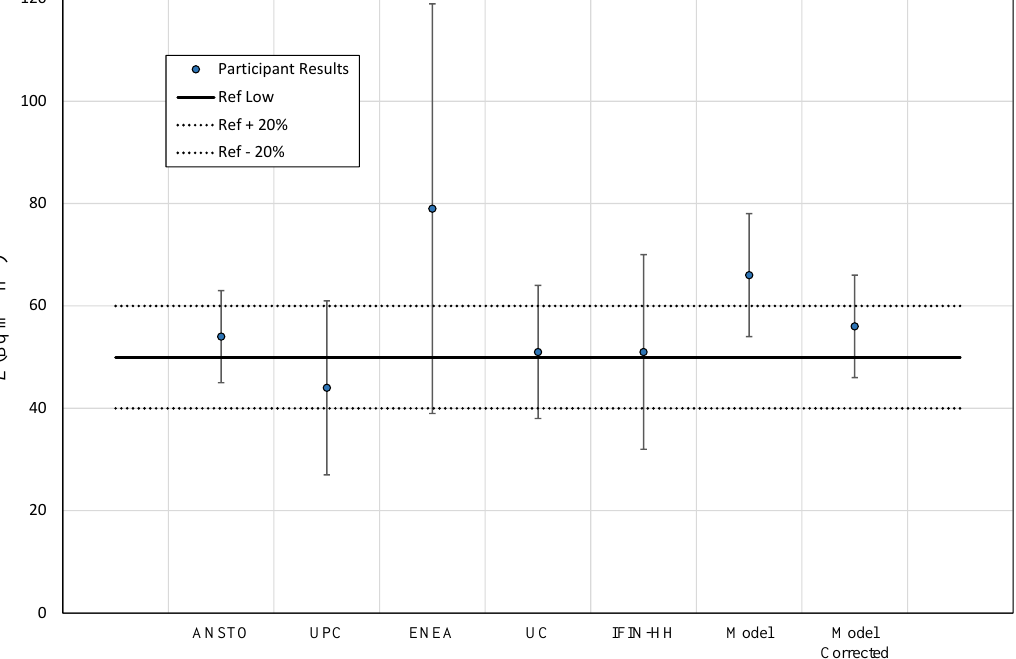
Figure 14. Participants results: average and reference value for the low radon flux area campaign.